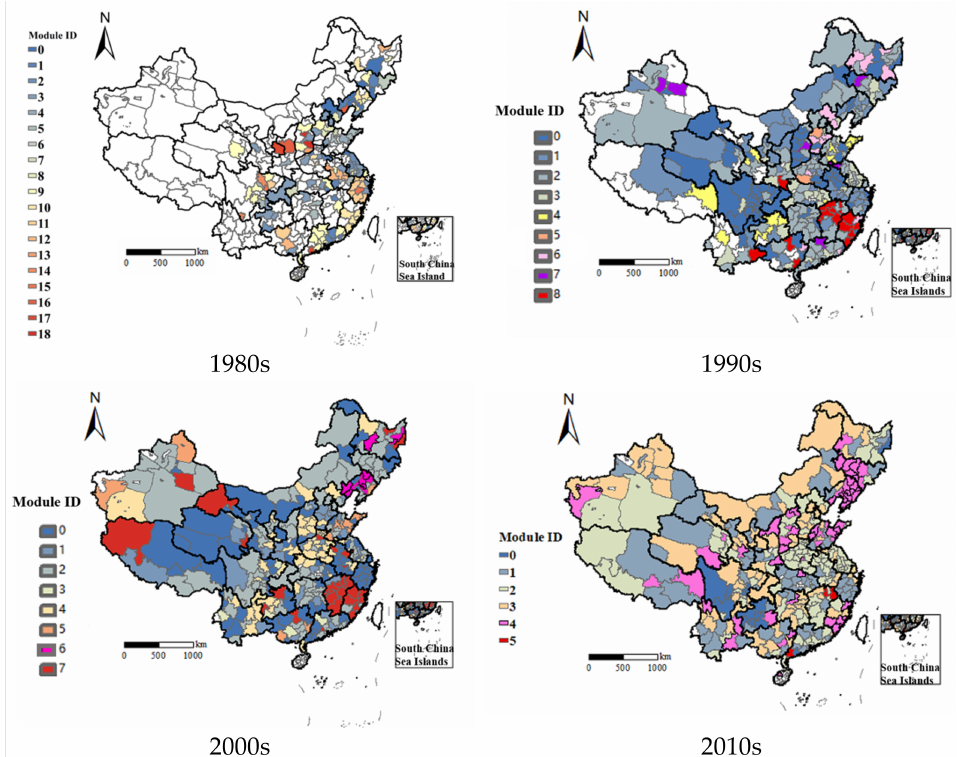
Figure 6. Module division of the corporate inter-city investment network in the 1980s, 1990s, 2000s, and